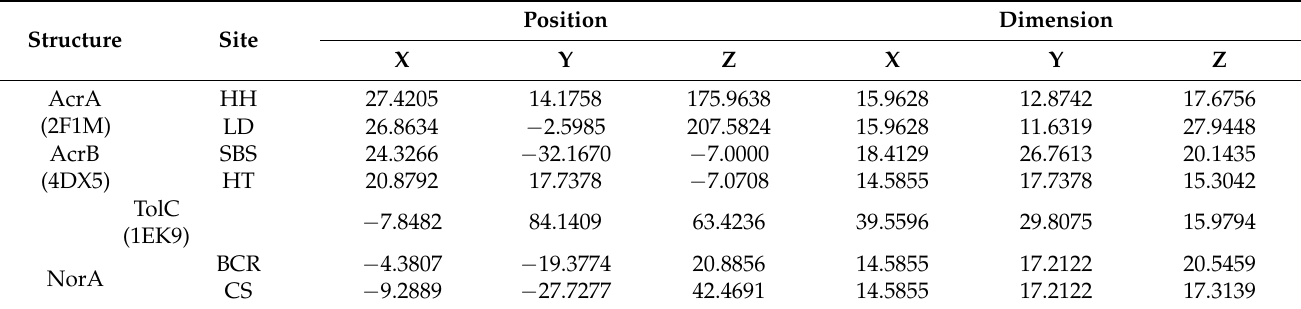
Table 4. Position and dimensions of the grid used to perform the docking